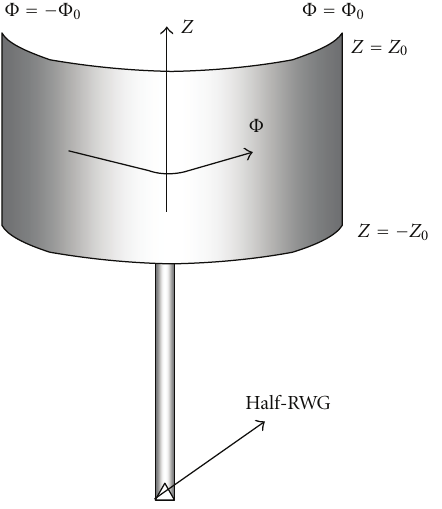
Figure 5: CCMA fed by